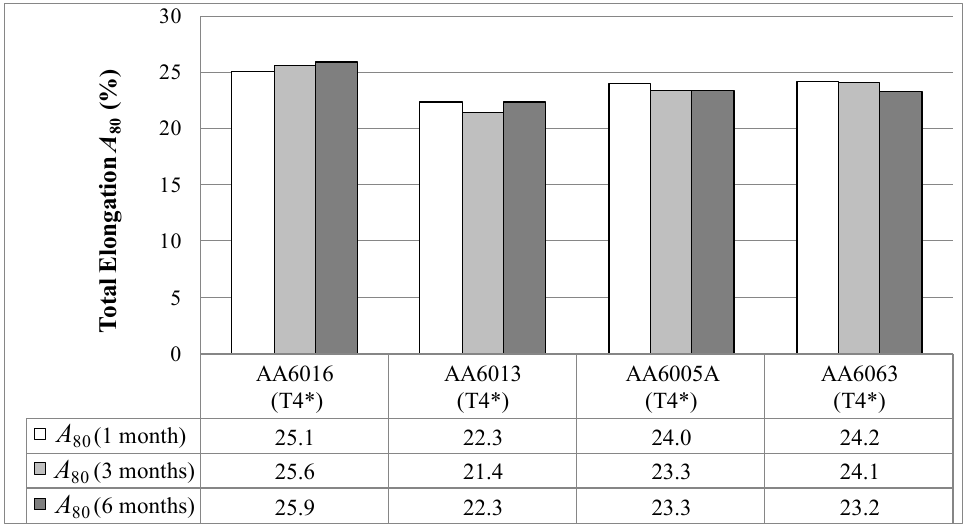
sheet production